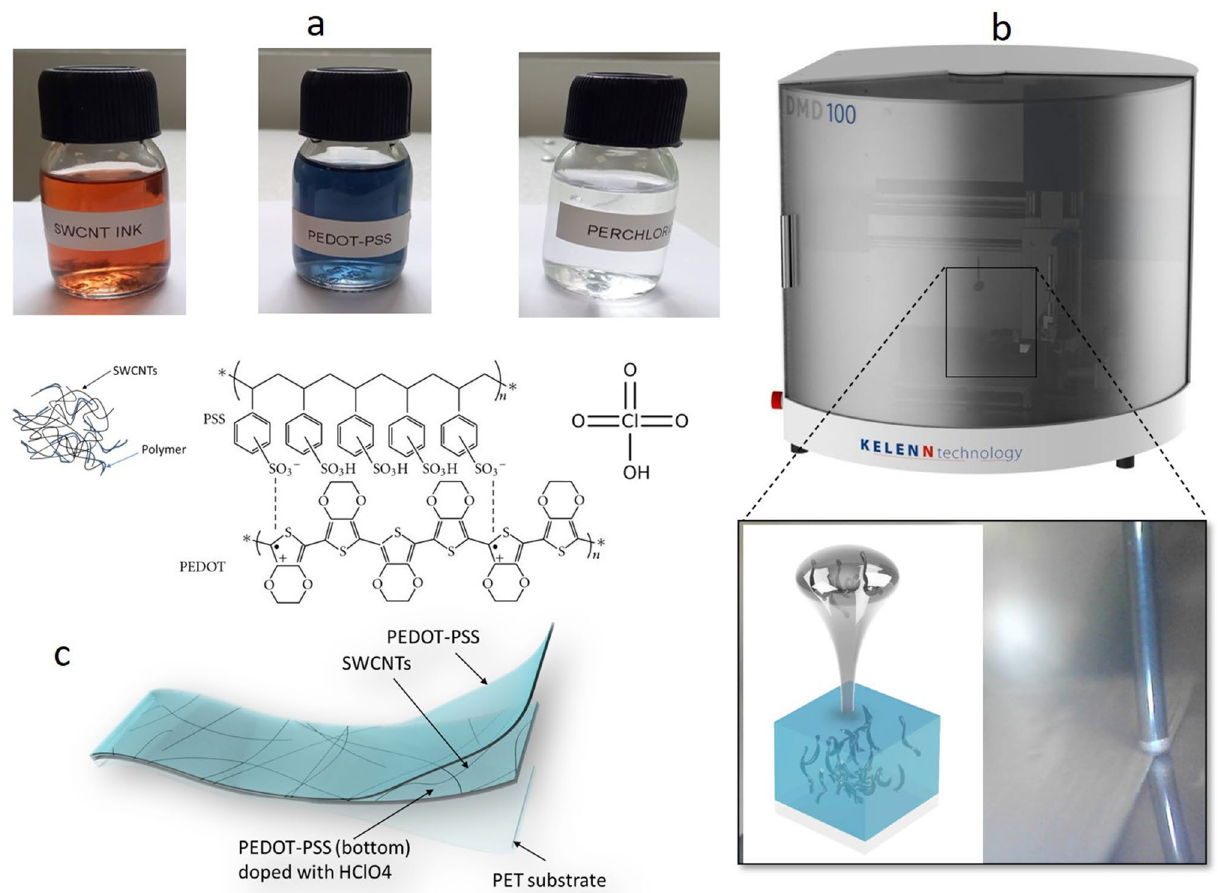
Figure 2. ( a ) Schematic illustration for the materials (SWNTs; PEDOT-PSS; HClO 4 ), ( b ) the digital materials deposition (DMD) machine used for the printing process. ( c ) Schematic illustration of PEDOT-SWCNTs (10:1) films doped with (0.1 M) HClO 4 digital printed on PET